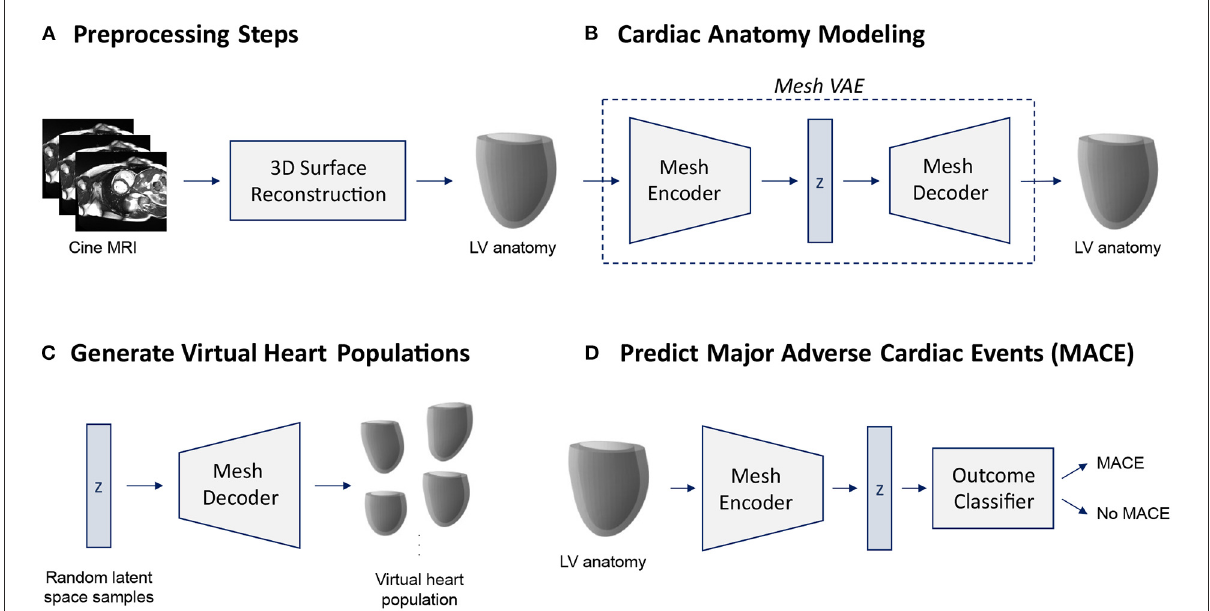
FIGURE1 Overview of the proposed cardiac shape analysis pipeline (A,B) and the two possible applications investigated in this work (C,D) . First, we pass raw cine MRI acquisitions through a multi-step 3D surface reconstruction pipeline (Section 2.2) to reconstruct 3D surface meshes of the left ventricular (LV) anatomy as a preprocessing step (A) . It consists of an image segmentation step using two cascaded U-Nets followed by a personalized template mesh fitting step based on variational warping techniques (Section 2.2). Next, as the core part of the pipeline, we propose a variational mesh autoencoder with an interpretable latent space z to efficiently capture population-wide variability in 3D cardiac shapes in a single geometric deep learning model (B) (Section 2.3). The decoder of the pre-trained mesh VAE can then be used to generate virtual population cohorts of 3D heart meshes (C) (Section 3.5). The pre-trained encoder converts input meshes into low-dimensional latent space representations which can serve as inputs to a MACE outcome classifier (D) (Section